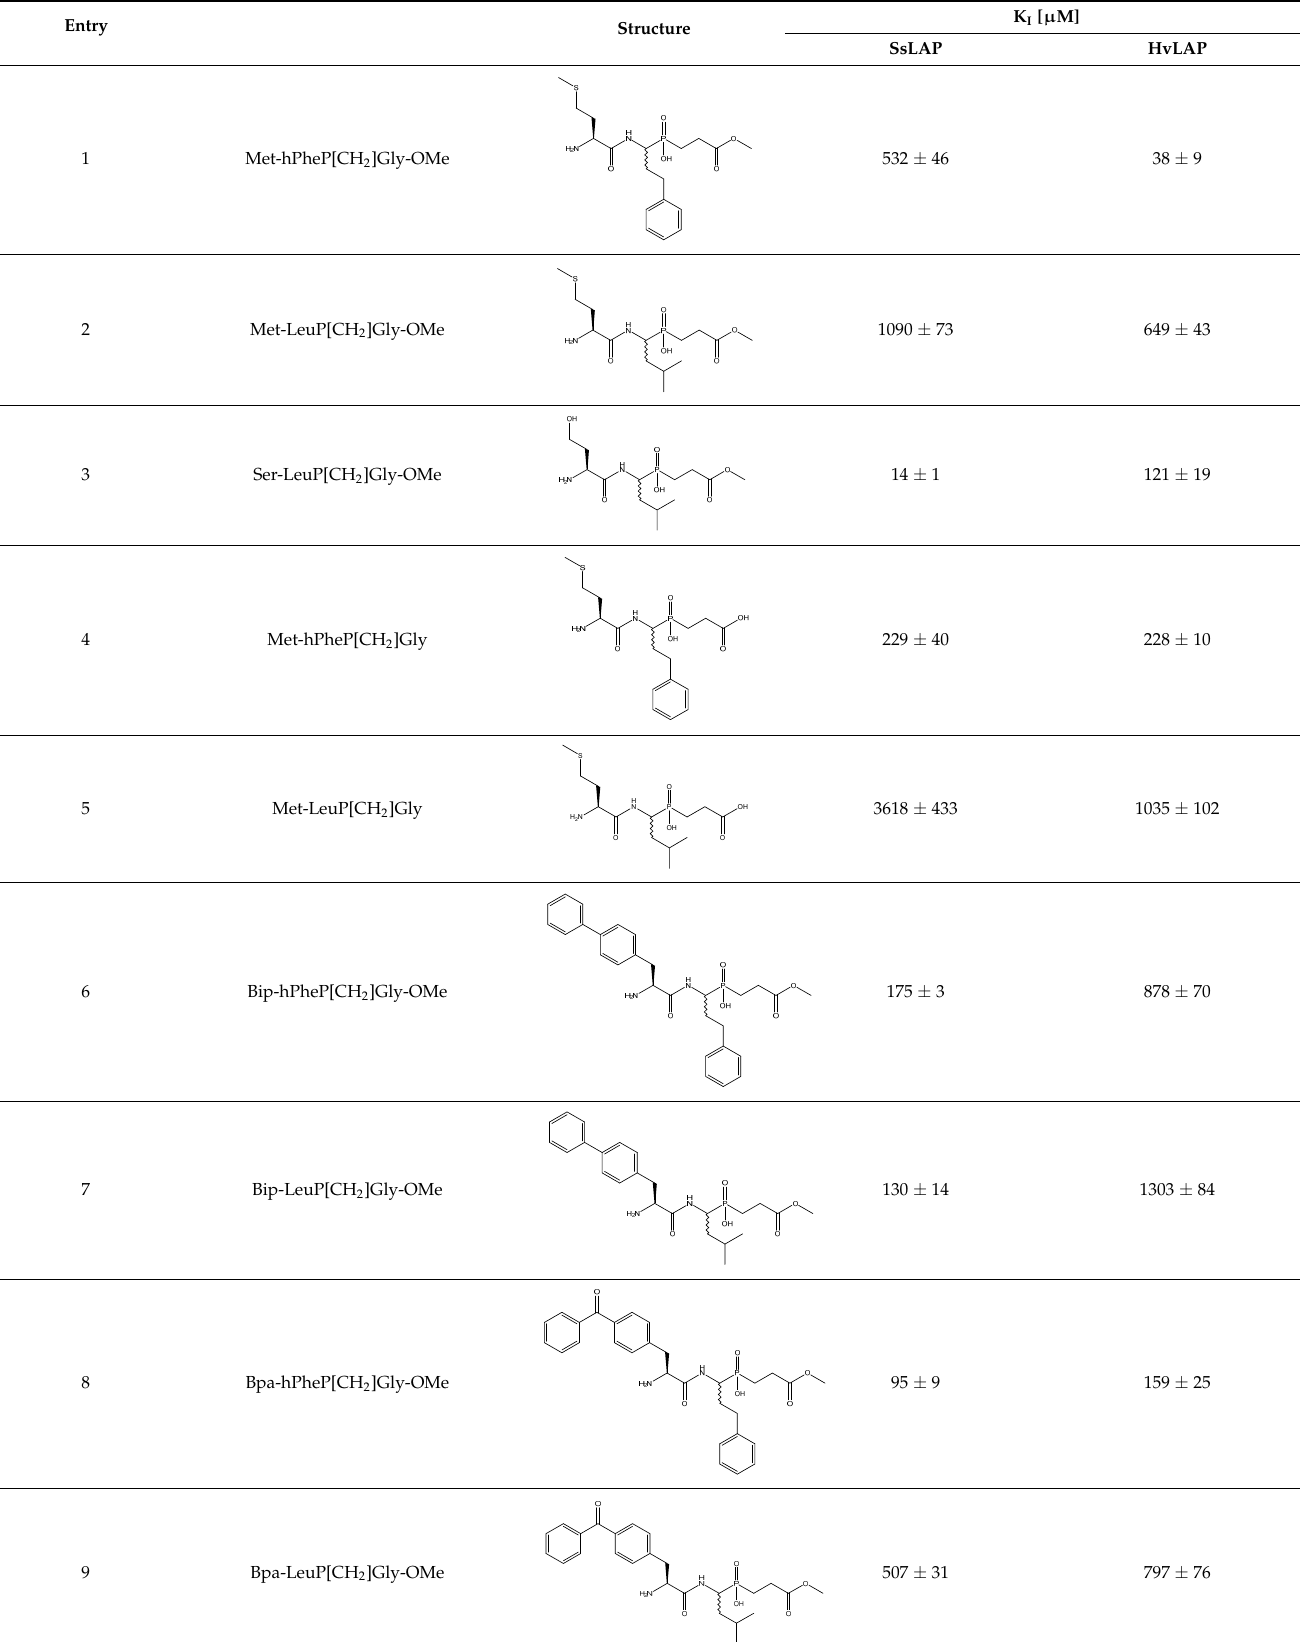
Table 1. The activity of pseudotripeptides as inhibitors of porcine LAP and barley LAP.